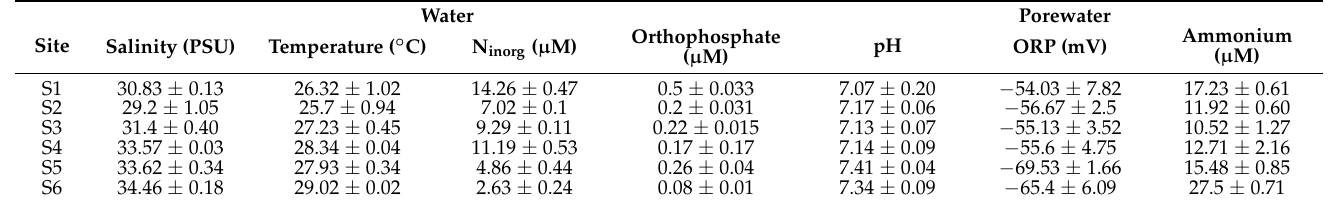
Table 1. Environmental characteristics and nutrient concentrations for water and porewater for all sampling stations. Inorganic nitrogen concentration (N inorg ) included ammonium, nitrate and nitrate contributions. Average of triplicates and standard deviation are presented.